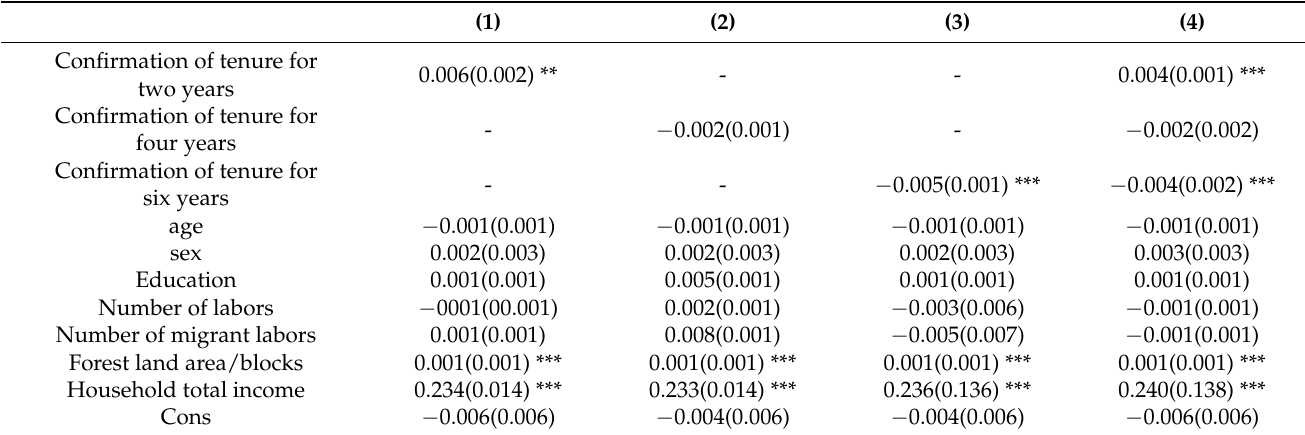
Table 2. The impact of primary reform of collective forest on farmers’